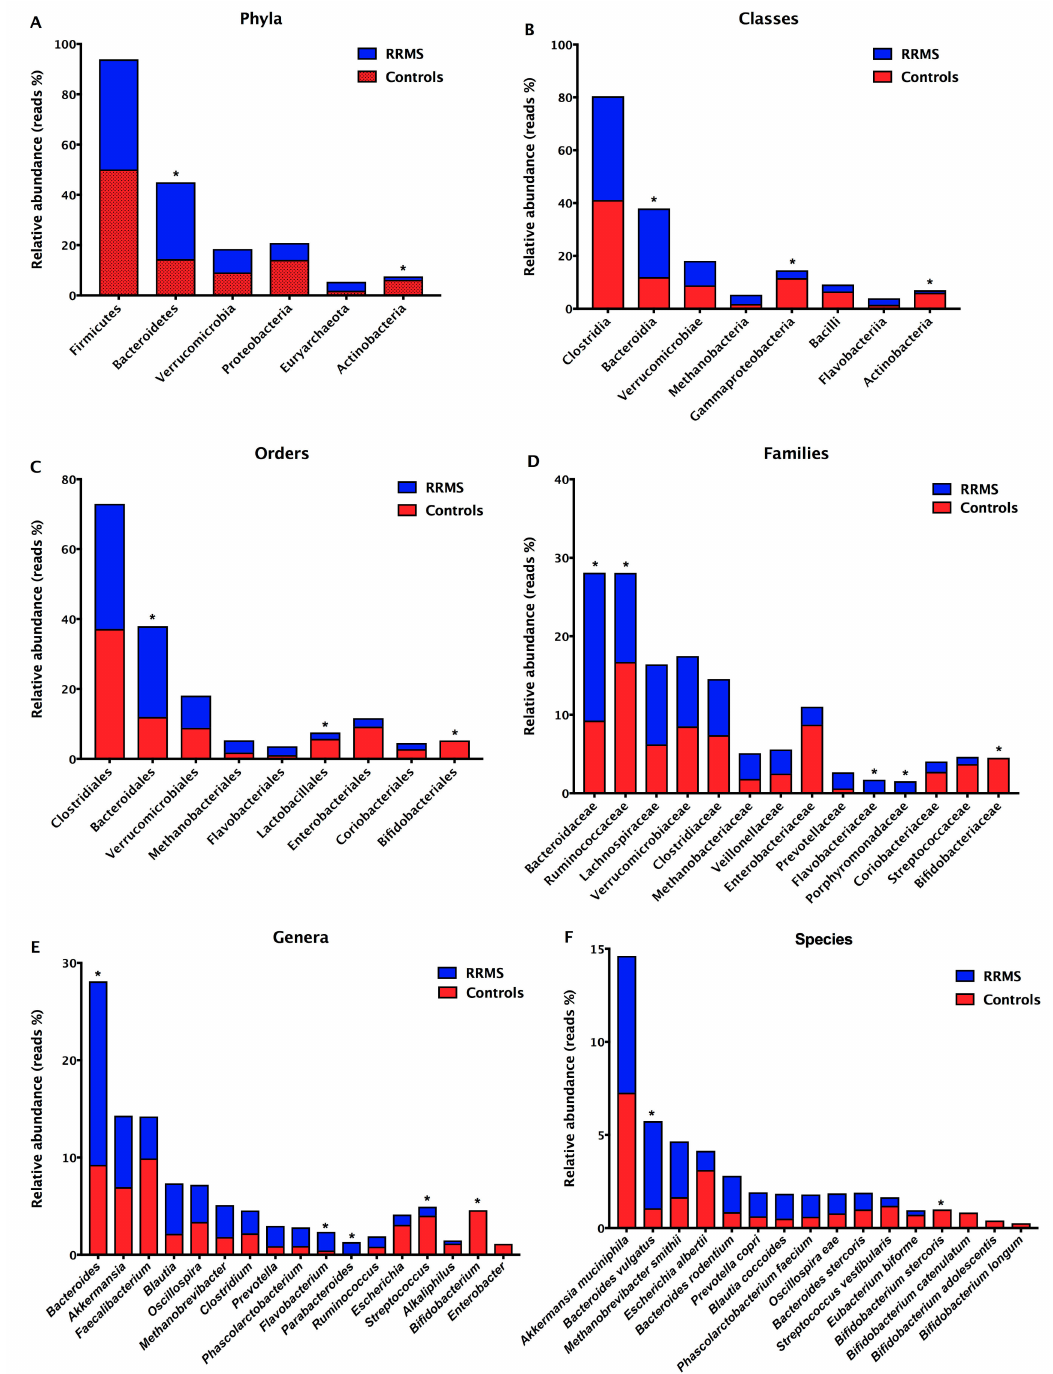
Figure 2. Relative abundances of bacterial taxa in stool samples from RRMS patients and controls. Predominant phyla ( A ), classes ( B ), orders ( C ), families ( D ), genera ( E ), and species ( F ). Bars represent the reads percentages found in metagenomics analyses. * p <